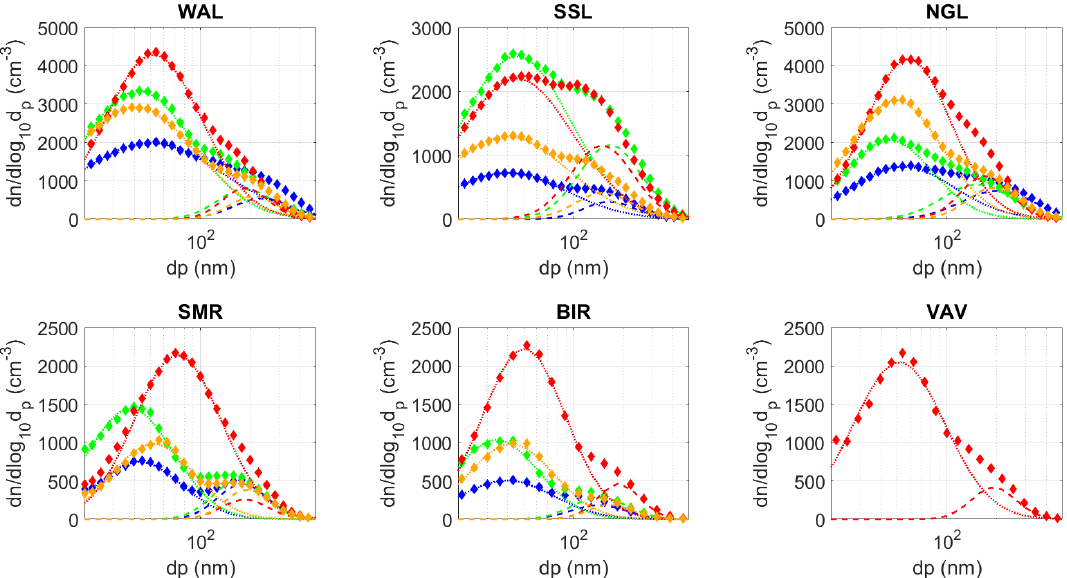
Figure A4. Median particle size distributions (diamonds) and corresponding modes (dotted lines) at forest continental sites. See Fig. A1 for an explanation of the